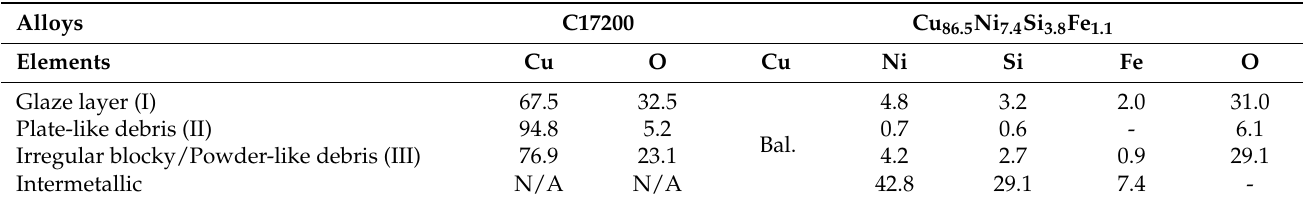
Table 2. Composition of wear surface and debris of C17200 and Cu 86.5 Ni 7.4 Si 3.8 Fe 1.1